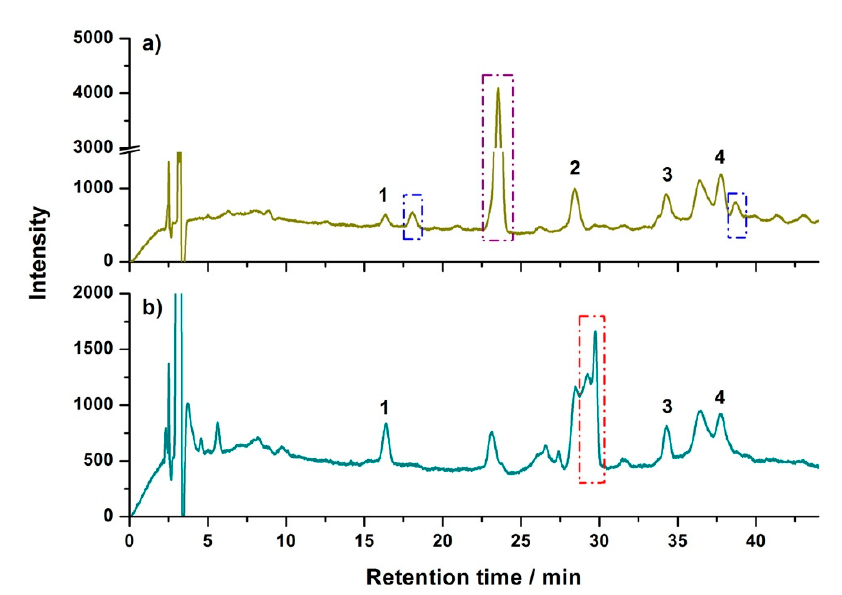
Figure 2. Representative chromatograms of extract cleaned up by ( a ) silica gel DPX, ( b ) dispersive solid-phase extraction (d-SPE). Peak 1: thiamethoxam, 2: acetamiprid, 3: thiacloprid, and 4: ethyl 6-chloropyridine-2-carboxylate (internal standard). The emerging peaks are marked in blue, the high-intensity peak from the matrix is marked in purple, and the matrix peaks overlapped with acetamiprid after d-SPE are marked in red.